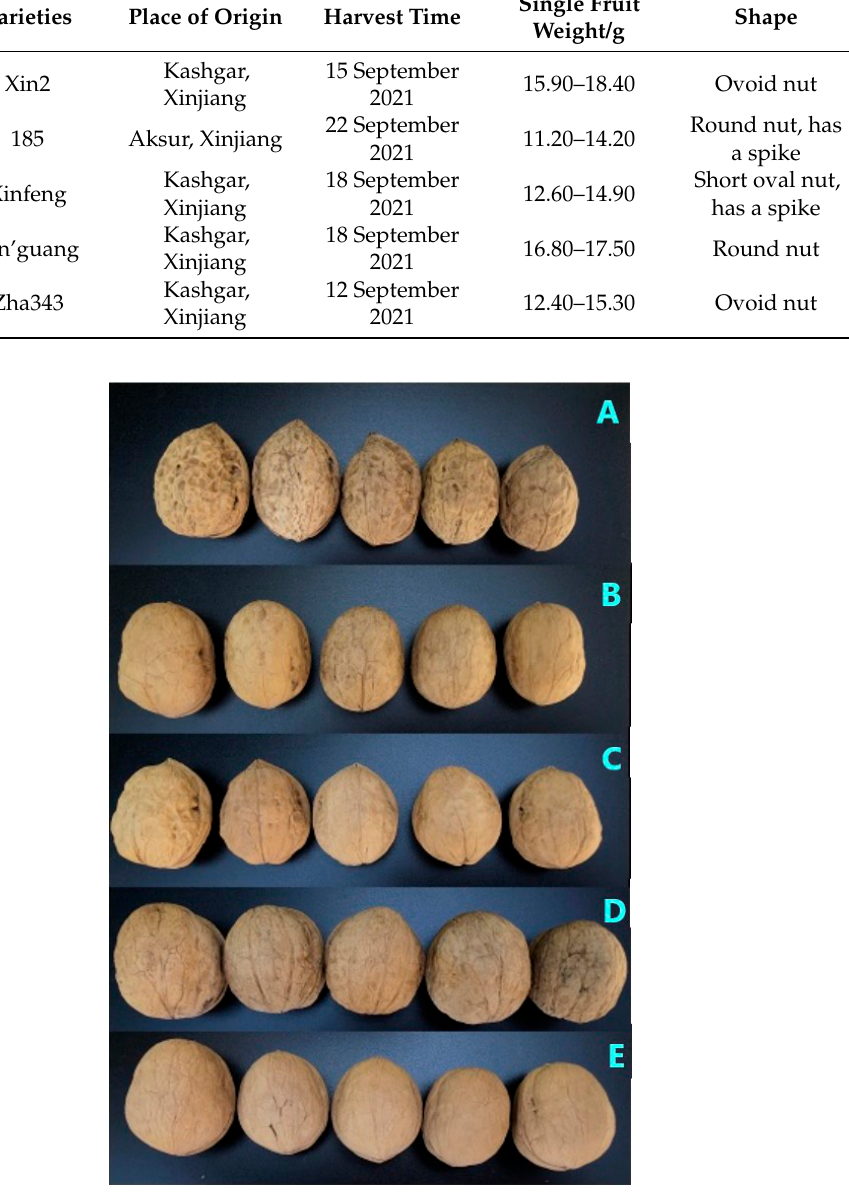
Figure 6. The appearances of walnuts from five